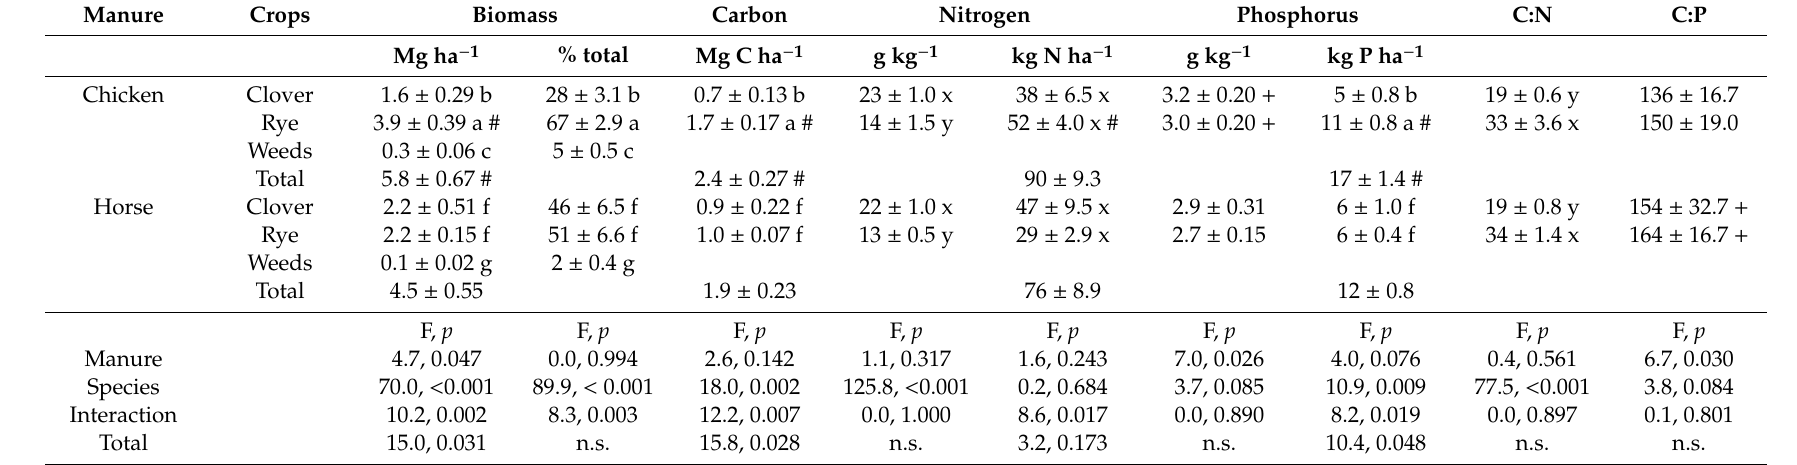
Table 3. Cover crop biomass, concentration, and recovery in aboveground biomass of carbon (C), nitrogen (N), and phosphorus (P), and nutrient ratios (mean ± standard error). Di ff erent letters denote significant di ff erences ( p < 0.05) among cover crops in chicken manure only (a, b, c), horse manure only (f, g, h), or in